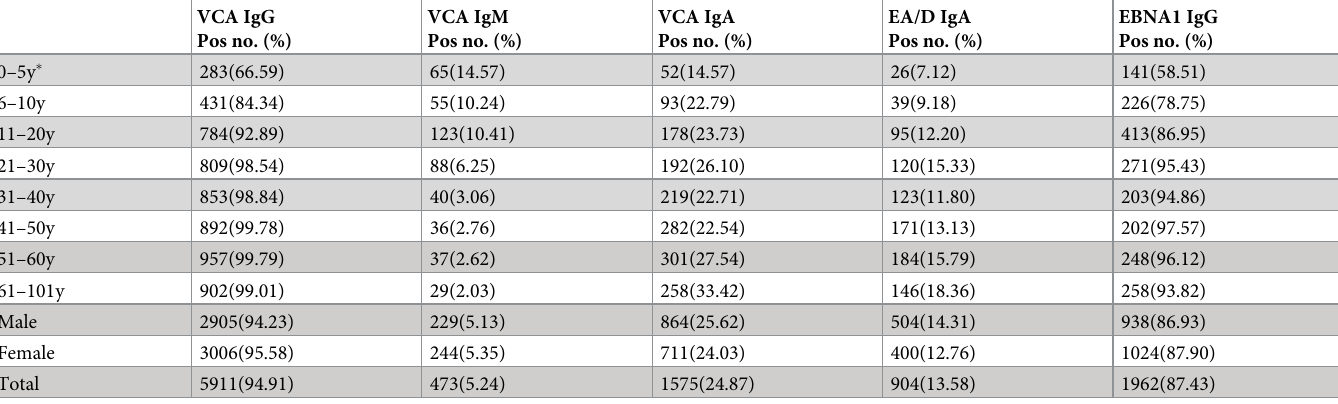
Table 1. Age related anti-EBV antibodies in all patients visiting the PUMC Hospital, Beijing, 2013–2017. VCA IgG Pos no. (%)